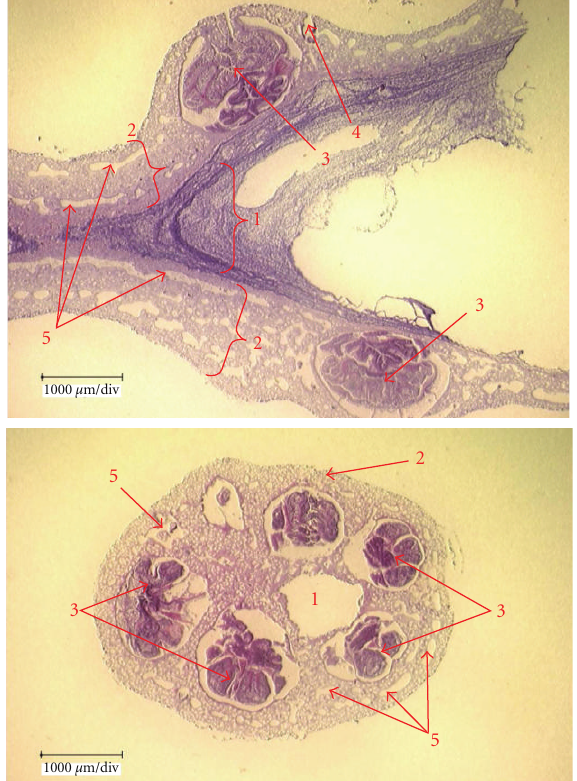
Figure 23: Histological sections of Corallium konojoi ; longitudinal section of OCA-Cn20090428-038 (above), and transverse section of OCA-Cn20060221-043 (below). 1: axis, 2: coenenchyme, 3: autozooid, 4: siphonozooid, 5: vascular